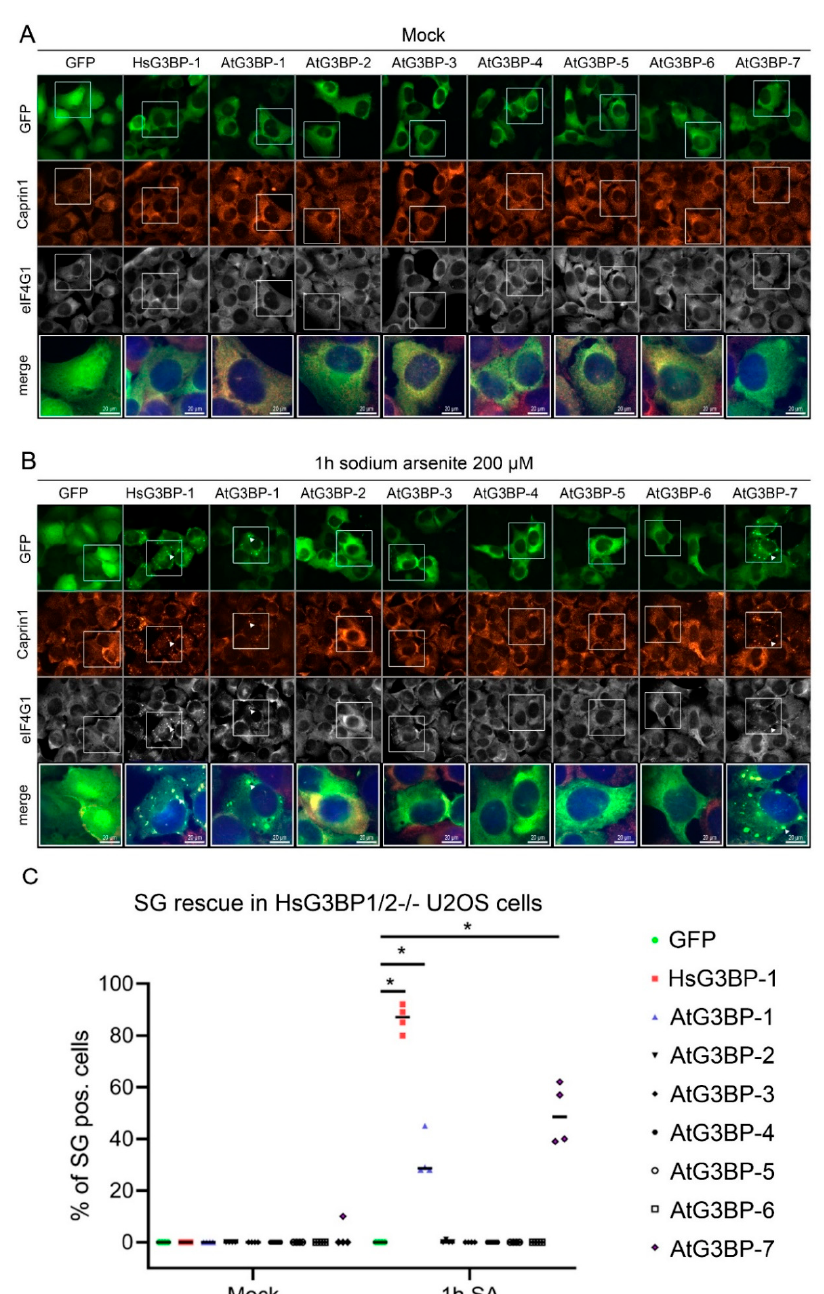
Figure 2. Complementation assay of the AtG3BP family in HsG3BP1/2 − / − U2OS cells stably expressing the indicated constructs. (A+B) HsG3BP1/2 − / − U2OS cells stably transfected with the different EGFP-G3BPs or free GFP under mock conditions ( A ) or after 1 h treatment with 200 µ M SA ( B ) stained for Caprin-1 (red), eIF4G1 (grey) and DNA (blue in the merged channel). Exemplary co-localization of G3BP, Caprin-1 and eIF4G1 is marked with an arrowhead. ( C ) Quantitative analysis of SG rescue in cells expressing the indicated construct. The asterisks indicate significance calculated by a Mann–Whitney U test (* = p < 0.05) compared to the GFP